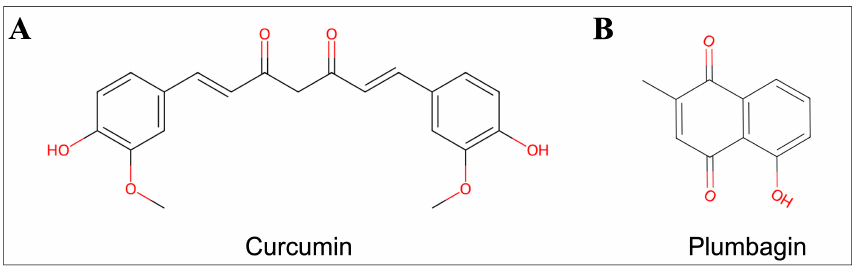
Figure 1. Chemical structures of ( A ) curcumin and ( B )